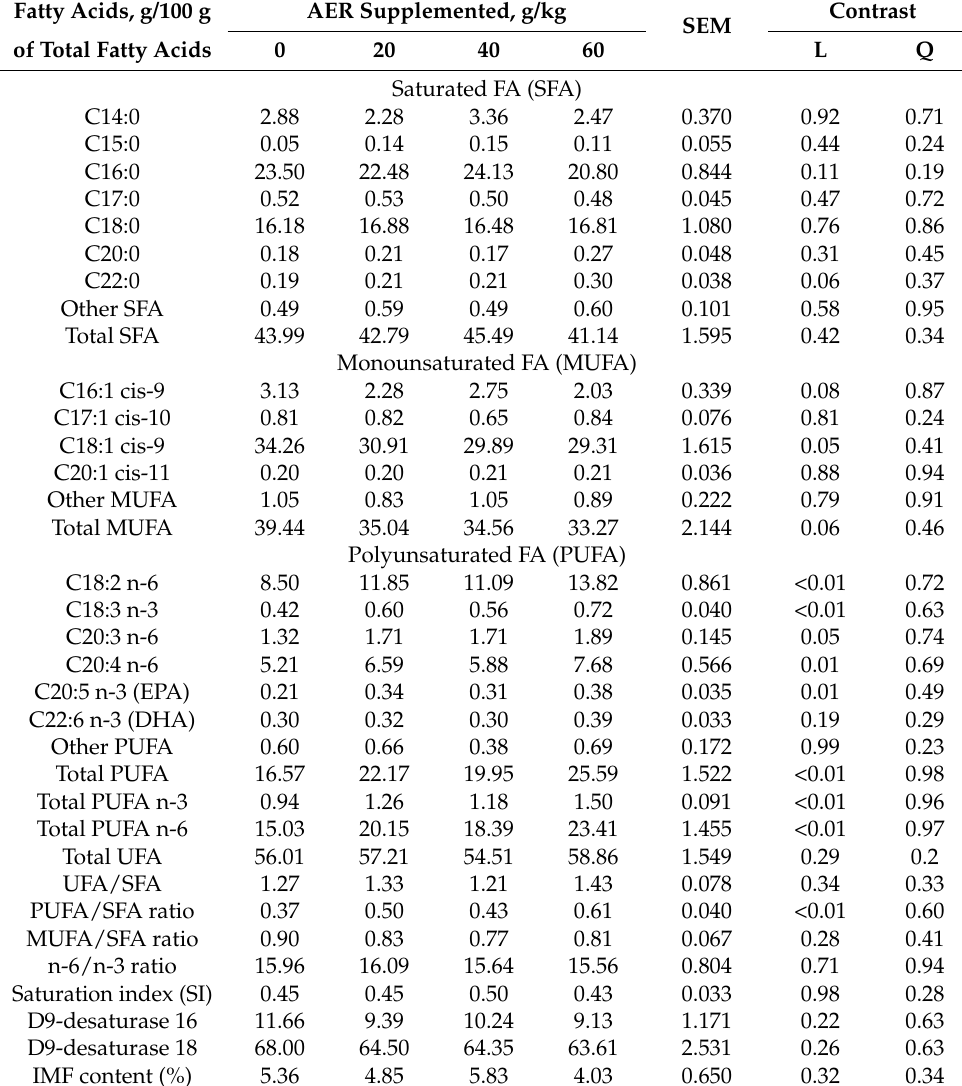
Table 4. Fatty acid (FA) composition (% of all fatty acids analyzed) of the lipids in LD of male dairy cattle with AER in TMR